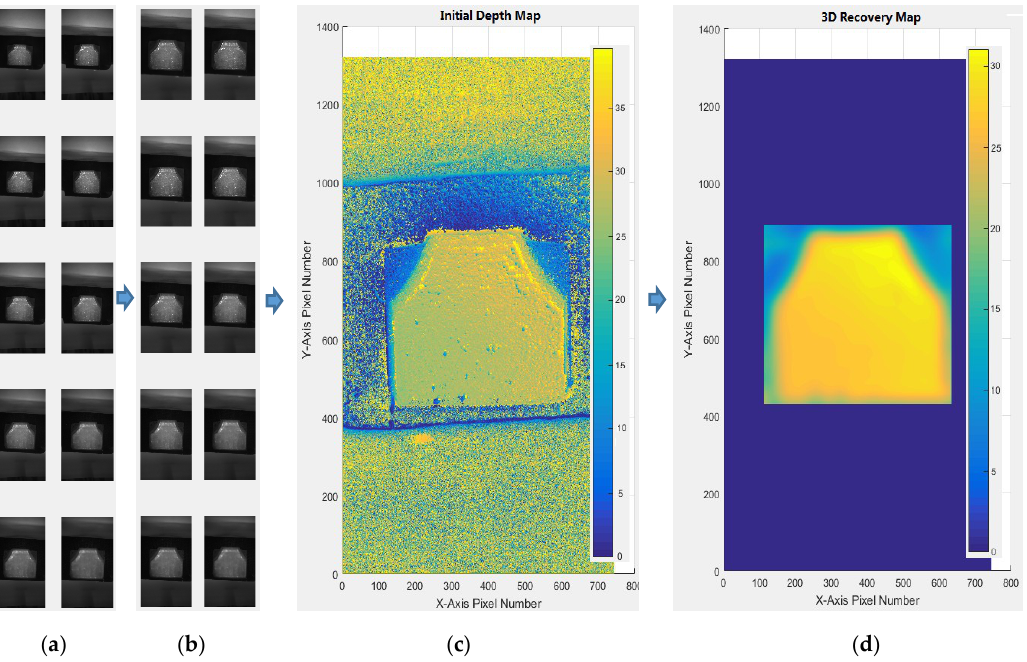
Figure 19. Image processing of the test: ( a ) the partial original images; ( b ) the partial pre-processed images; ( c ) the initial depth map; ( d ) the 3D recovery map.